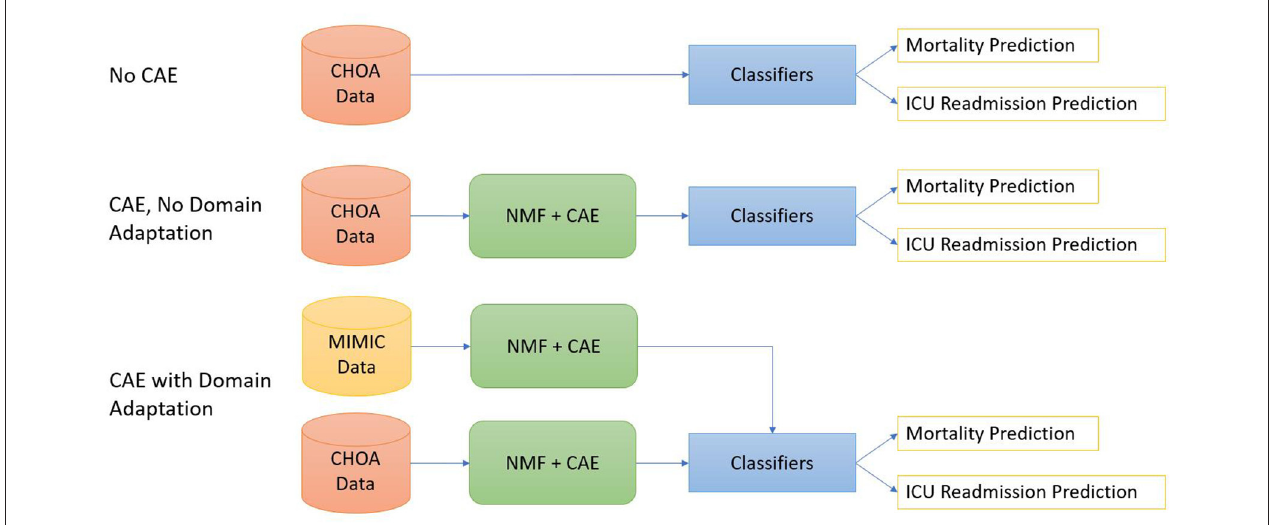
FIGURE 2 | Diagrams for three experiments settings. The top one is to apply classifiers directly on the Children’s Healthcare of Atlanta (CHOA) data. The middle one is to apply non-negative matrix factorization (NMF) and convolutional autoencoder (CAE) on CHOA without domain adaptation. The bottom one is domain adaptation using CAE.